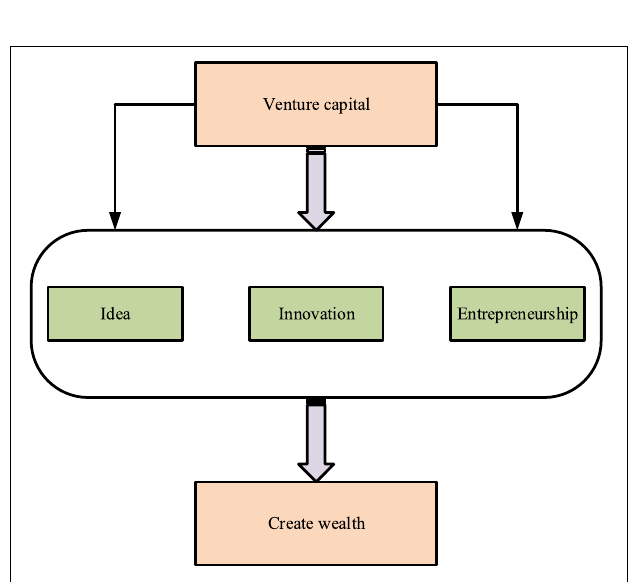
FIGURE 2 | Elementary objects of innovation and entrepreneurship education in colleges and